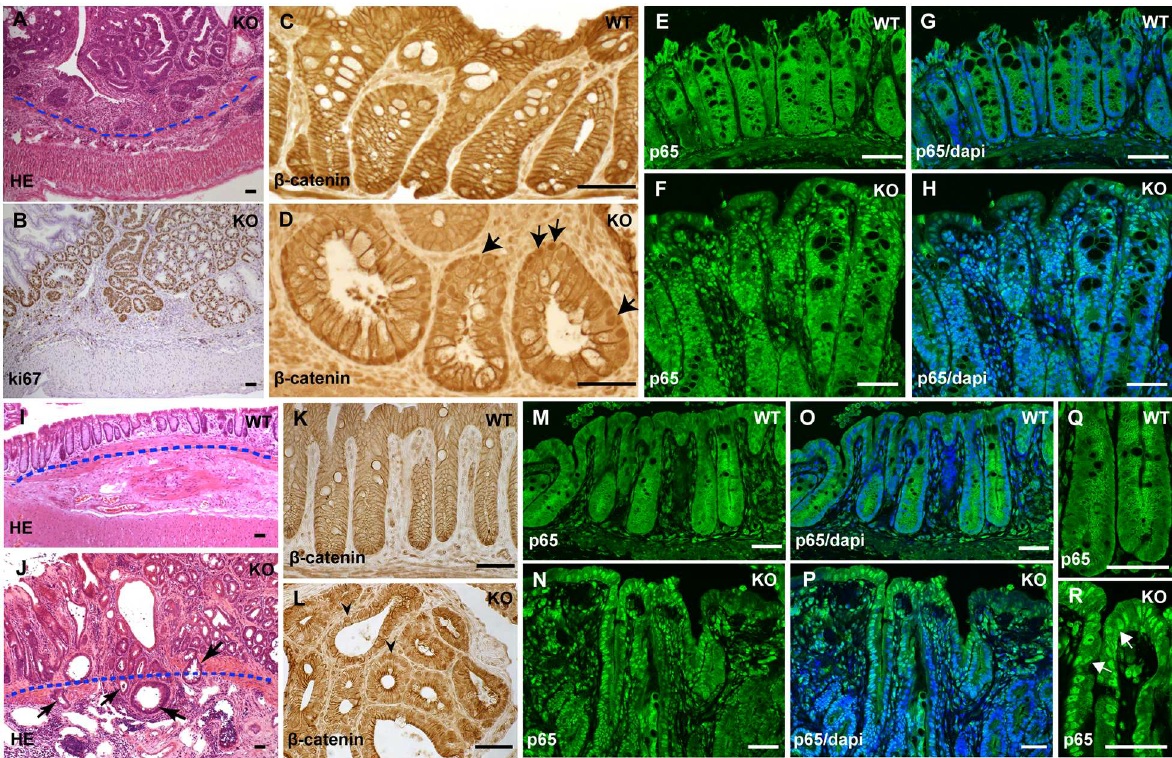
Fig 4. The IEC-specific hnRNPI knockout mice develop colorectal neoplasia with highly active Wnt and NF- κ Bsignaling. (A) HE–stainedsection shows non-invasive neoplasiain the colonicepitheliumof the knockout mouse. The dotted line indicatesthe position of muscularis mucosae. (B) Immunohistochemicalstaining with an anti-Ki67antibodyshows hyperproliferation in colonicneoplasia.(C) and (D) Immunohistochemicalstaining with an anti- β -Catenin antibody shows nuclear translocation of β -Cateninin the colonicepithelium of the knockout mice (D, arrows). In the wild-typecolonicepithelium, β -Cateninis membranelocalized(C). (E) to (H) Immunofluorescence staining with an anti-p65antibodyshows p65 nucleartranslocationin the colonic epithelium of the knockout mice (F and H). p65 is mainly localizedin the cytoplasm in the control mice (E and G). Nuclei were counterstained with DAPI (G and H). (I) and (J) HE–stainedsection shows invasiveadenocarcinomas in the prolapsedrectum of the knockout mouse. The dotted line indicatesthe positionof muscularismucosae. Note a few glandshave invadedthrough the muscularismucosae into the submucosa (arrows in J). (K) and (L) Immunohistochemicalstainingshows nuclear accumulation of β -Cateninin the rectal epithelialcells in the knockout mice (arrowheads in L), whereasin the control rectal epithelium, β -Cateninis cell membranelocalized(K). (M) to (R) Immunofluorescence stainingshows nucleartranslocationof p65 in the rectal epitheliumof the knockoutmice (N, P and R). The control mice showed cytoplasmic localization of p65 (M, O and Q). Nuclei were counterstained with DAPI (O and P). (Q) and (R) High magnification shows p65 nuclearlocalizationin the rectal epithelialcells. WT, wild-type;KO, knockout. Scale bars, 50 μ m.